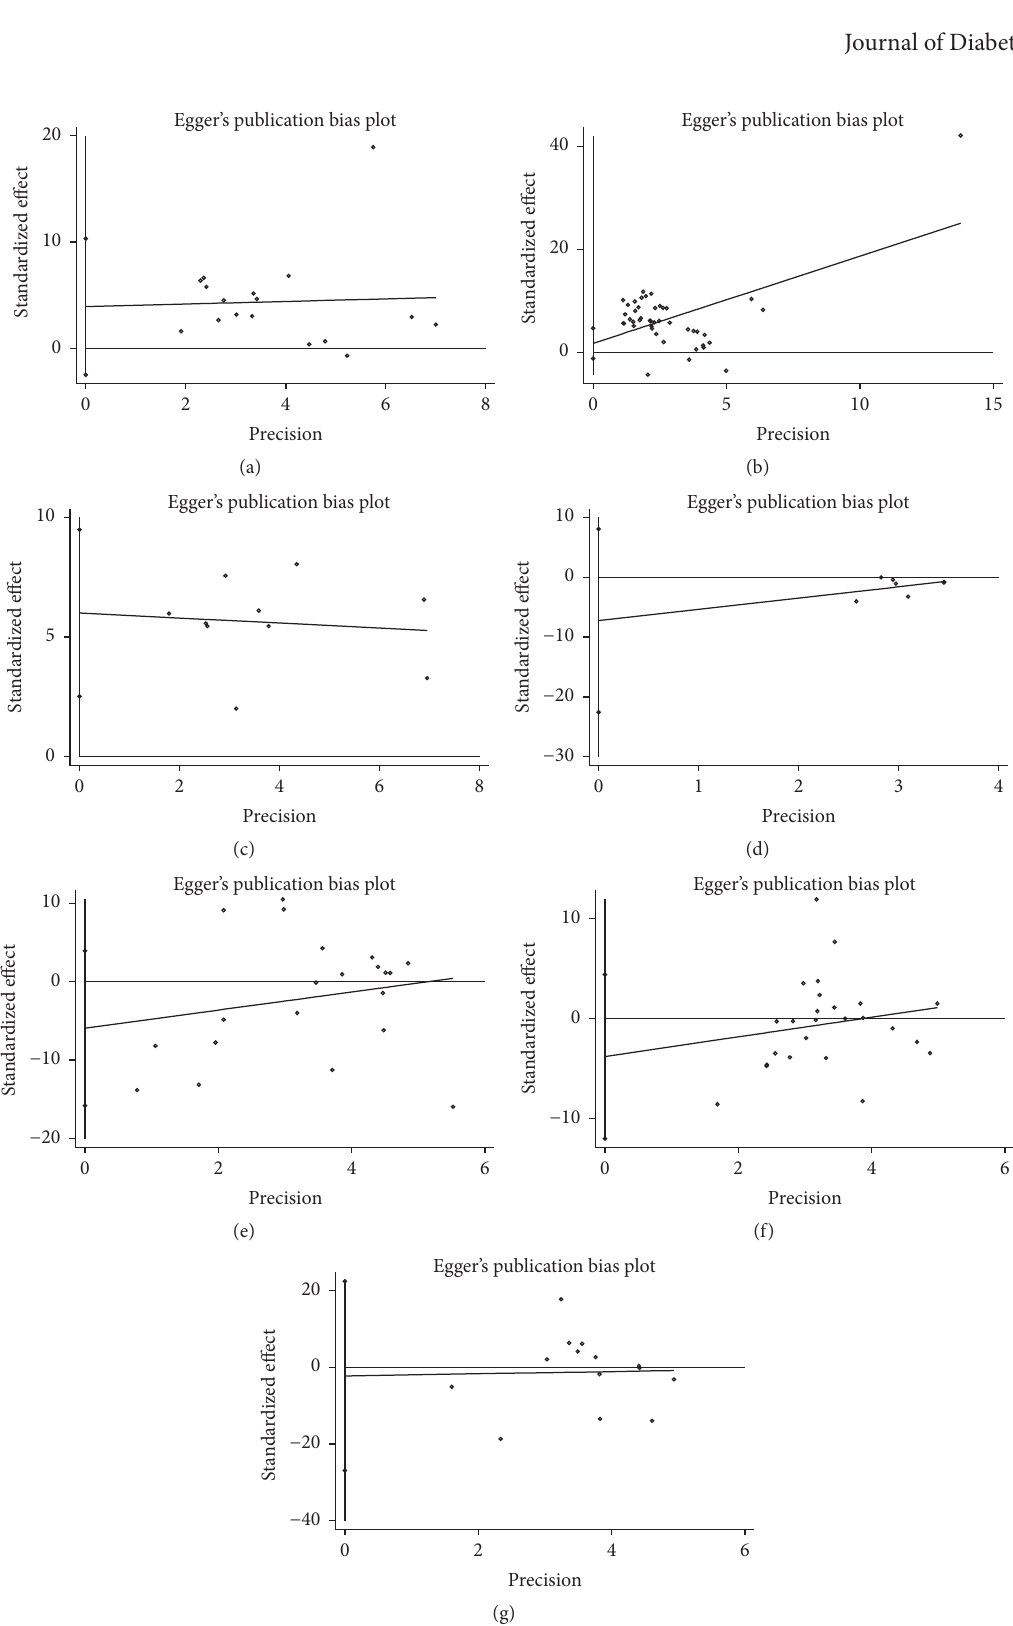
Figure 9: Egger’s test about the Treg and cytokines for publication bias ((a) IL-6, t = 1.31, p = 0.209, CI, − 2.46 to 10.33; (b) TGF- 𝛽 , t = 1.20, p = 0.238, CI, − 1.20 to 4.69; (c) TNF- 𝛼 , t = 3.98, p = 0.004, CI, 2.52 to 9.49; (d) CD4 + CD25 + Foxp3 + Treg, t = − 1.22, p = 0.277, CI, − 22.58 to 8.05; (e) IL-10, t = − 1.26, p = 0.223, CI, − 15.80 to 3.93; (f) CD4 + CD25 + Treg, t = − 0.95, p = 0.351, CI, − 11.97 to 4.43; (g) IL-17, t = − 0.20, p = 0.845, CI, − 26.99 to